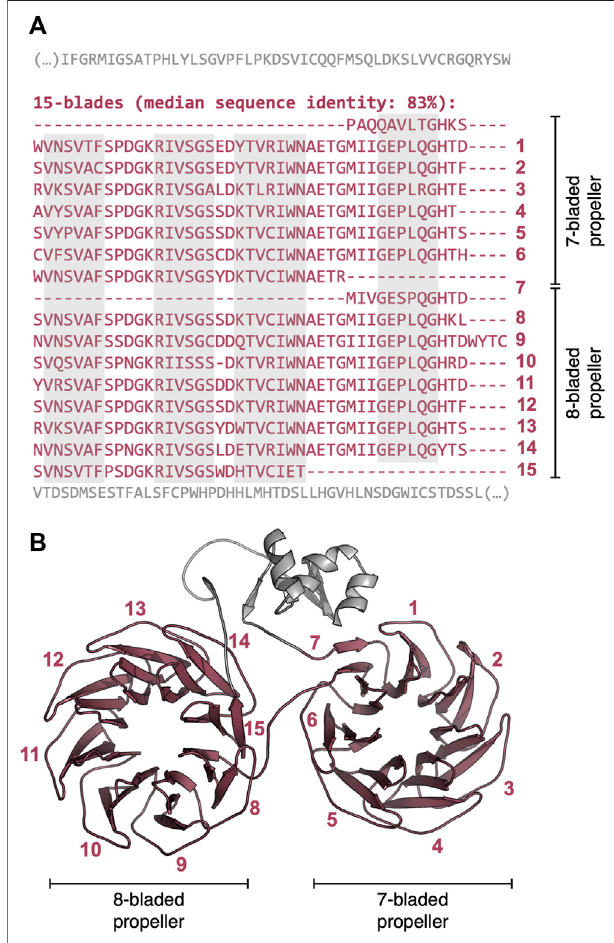
FIGURE6| Thegloballyhighlyrepetitive β -propeller ofWD40repeat-like proteinKAE9403162.1fromGymnopus androsaceusJB14. (A) Annotated β - propeller sequence, highlighting the 15 nearly identical, consecutive blades and the fl ankingnon-propellersequences. Theindividualstrandsineach β -propeller blade are highlighted in grey. (B) Three-dimensional model of the β -propeller and immediate fl anking regions predicted with AlphaFold v2.1.2 (Jumper etal.,2021) (QMEANDisCo Global (Studer et al., 2020) scoreof 0.65 ± 0.05, average pLDDT (Jumper et al., 2021) of 88.9). Modelling was carried out with the full-length protein sequence but only the region whose sequence is shown in (A) is depicted.